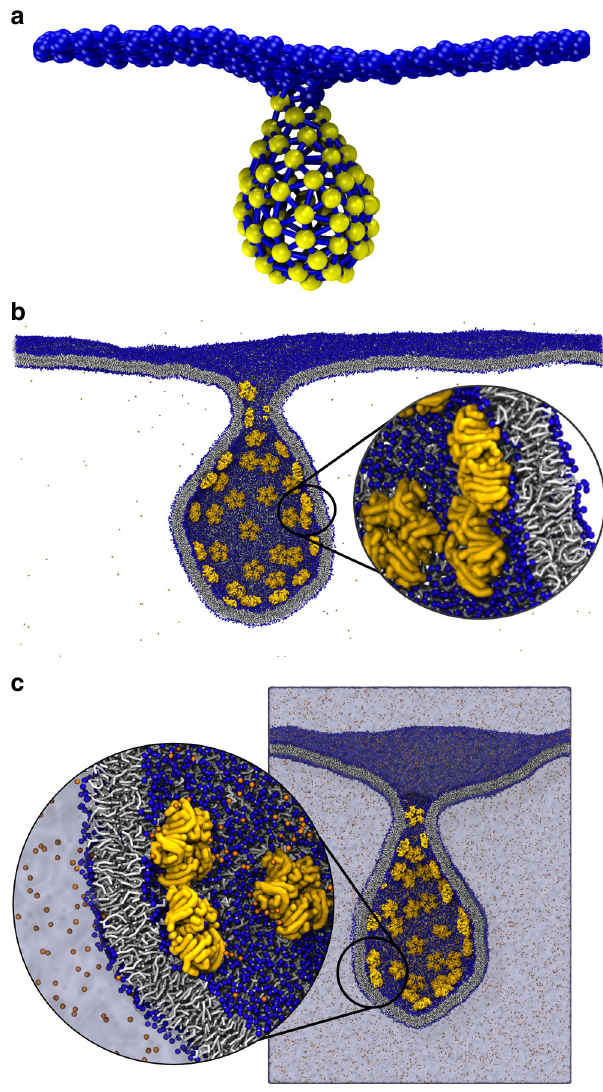
Fig. 4 Backmapping of an endocytic bud formed by STxB proteins. a Con fi guration obtained from DTS simulation. Yellow beads are vertices occupied by STxB inclusion, Blue beads are vertices representing the membrane surface. b Con fi guration from the solvent-free CG Martini model, after a 200 ns simulation starting from the backmapped DTS structure. Yellow objects are STxB proteins, orange dots are ions, blue beads are phosphate groups of the DOPC lipids and lipid chains are shown in gray. c Final CG con fi guration obtained with standard Martini model after a 50 ns simulation. The color code is the same as b